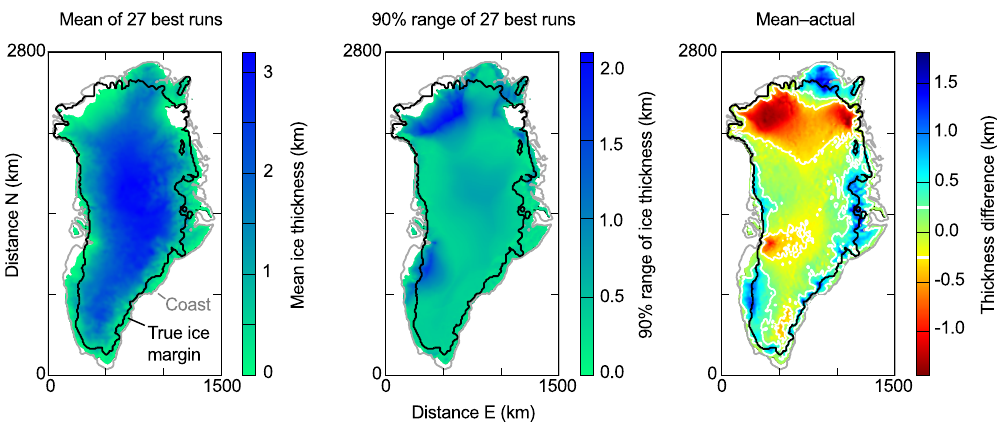
Fig. 7. Comparison of the spatial distribution of mean ice thickness among the 27 “best” model runs to the observed modern ice geometry. By “best” runs, we mean those that give ice volumes within 10% of the estimated modern ice volume in 2005 AD (Bamber et al., 2001; Sects. 3.4, 4.6). 90% range: difference between 95th and 5th percentiles of ice thickness values within each grid cell. Black line: modern ice margin; gray line: coast (Bamber et al., 2001, as gridded by Greve et al., 2011); white line: contour bounding areas where the differences between the observed and mean modeled ice thicknesses are less than 250m. Simulated ice thicknesses are generally too large near the margins, but there are large areas of too-thin ice in the northern part of Greenland and upflow from Jakobshavn (about a third of the way northward on the western